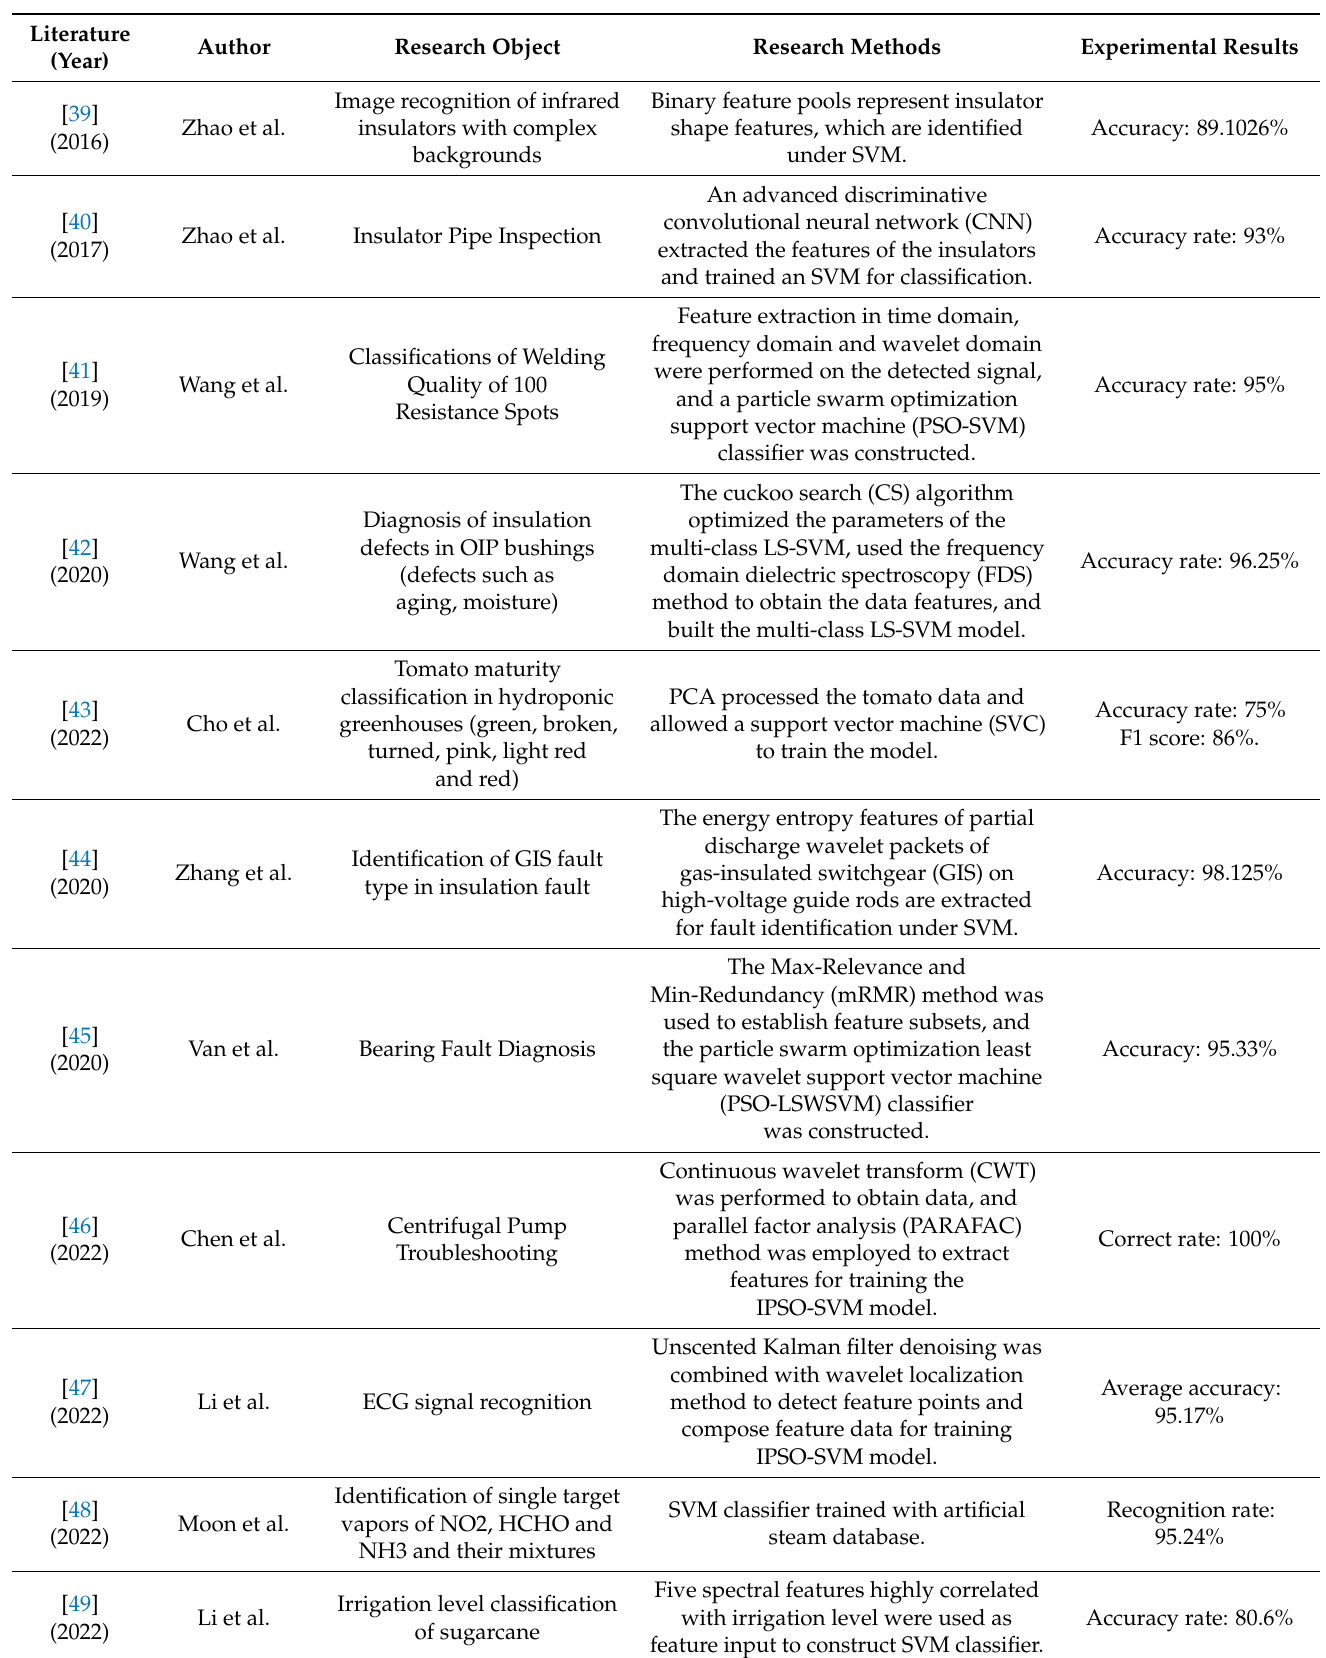
Table 1. Literature summary of SVM